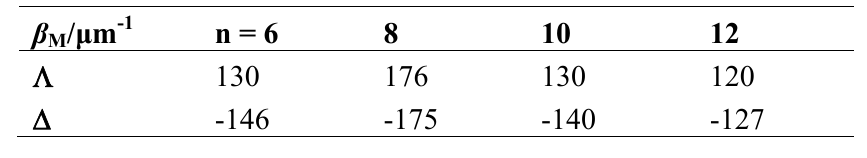
L C ] and 2 per n